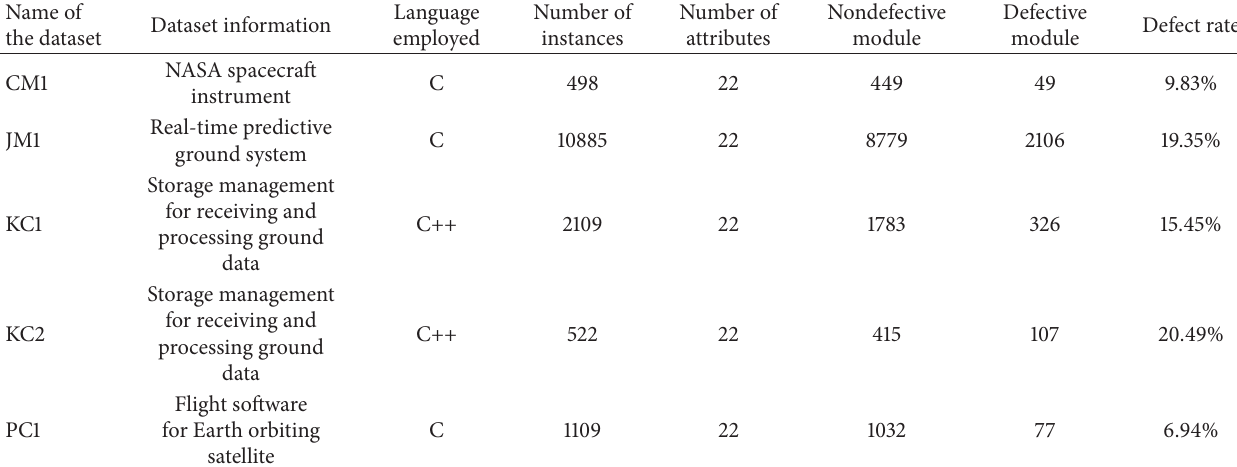
Table 1: Description of datasets used in this study [12].